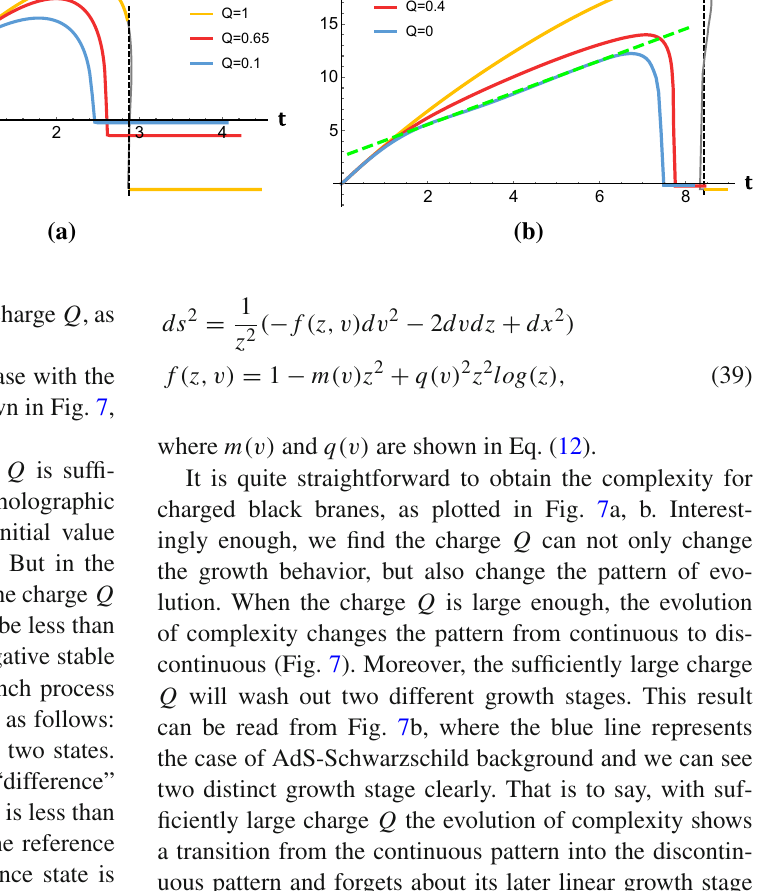
Fig. 7 The impact of the charge Q on the evolution of subregion complexity in three dimensional RN-AdS background ( b = 0). In Fig. 7b, the green dashed line represents the linear growth stage at later time when l is large